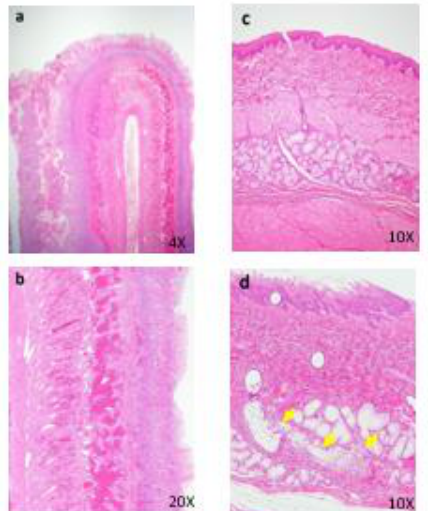
Figure 5: Histo- Figure 6: Histopathological findings in intestine. 50 mg/kg (a), Hyper view from lesion (b), a , The intussusception is seen. b , Peritonitis, necrosis and hemorrhage of intestinal walls are seen. His- topathological findings in esophagus. Control (c), 50 mg/kg (d), c , No abnormalities detected. d , Fo- cal inflammation of esophageal gland (arrows) is seen.